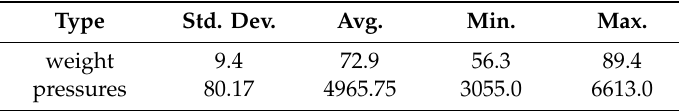
Figure 5. The grey scale image of the three pressure distributions for the same subject. Table 1. The statistical characteristics of the